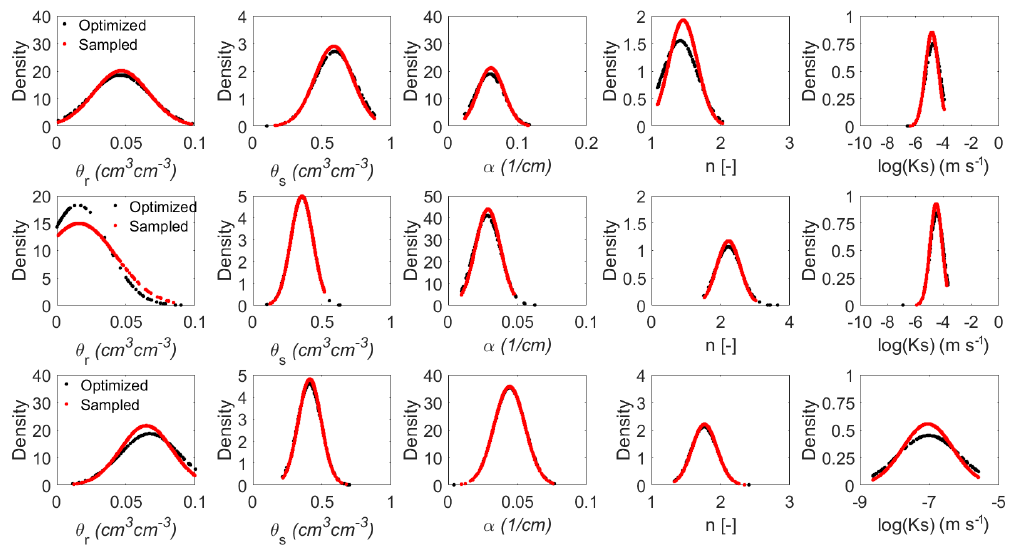
Figure 6. PDFs for the optimized and sampled 700 parameter sets for the peat cover soil (top row), subsoil (middle row), and LOS (bottom row). Table 3. Mean and SD values of the optimized and randomly sampled parameters for peat, subsoil, and LOS. The differences between the corresponding mean and SD of the sampled and optimized parameter values are shown as percentages. Parameter Peat Subsoil LOS Optimized Sampled Error (%) Optimized Sampled Error (%) Optimized Sampled Error (%) 0.0460